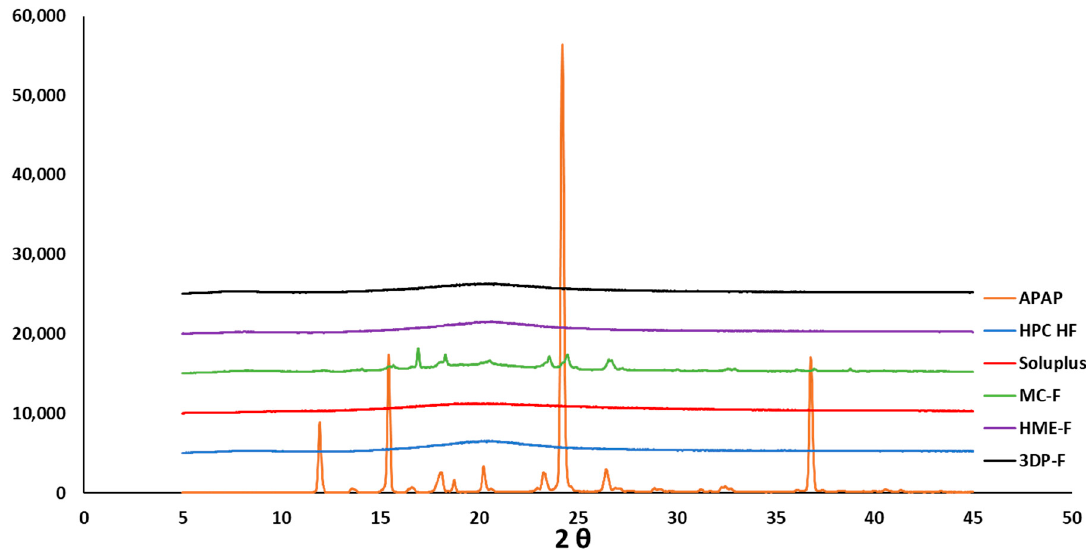
Figure 5. P-XRD curves of raw materials and films prepared via different methods.